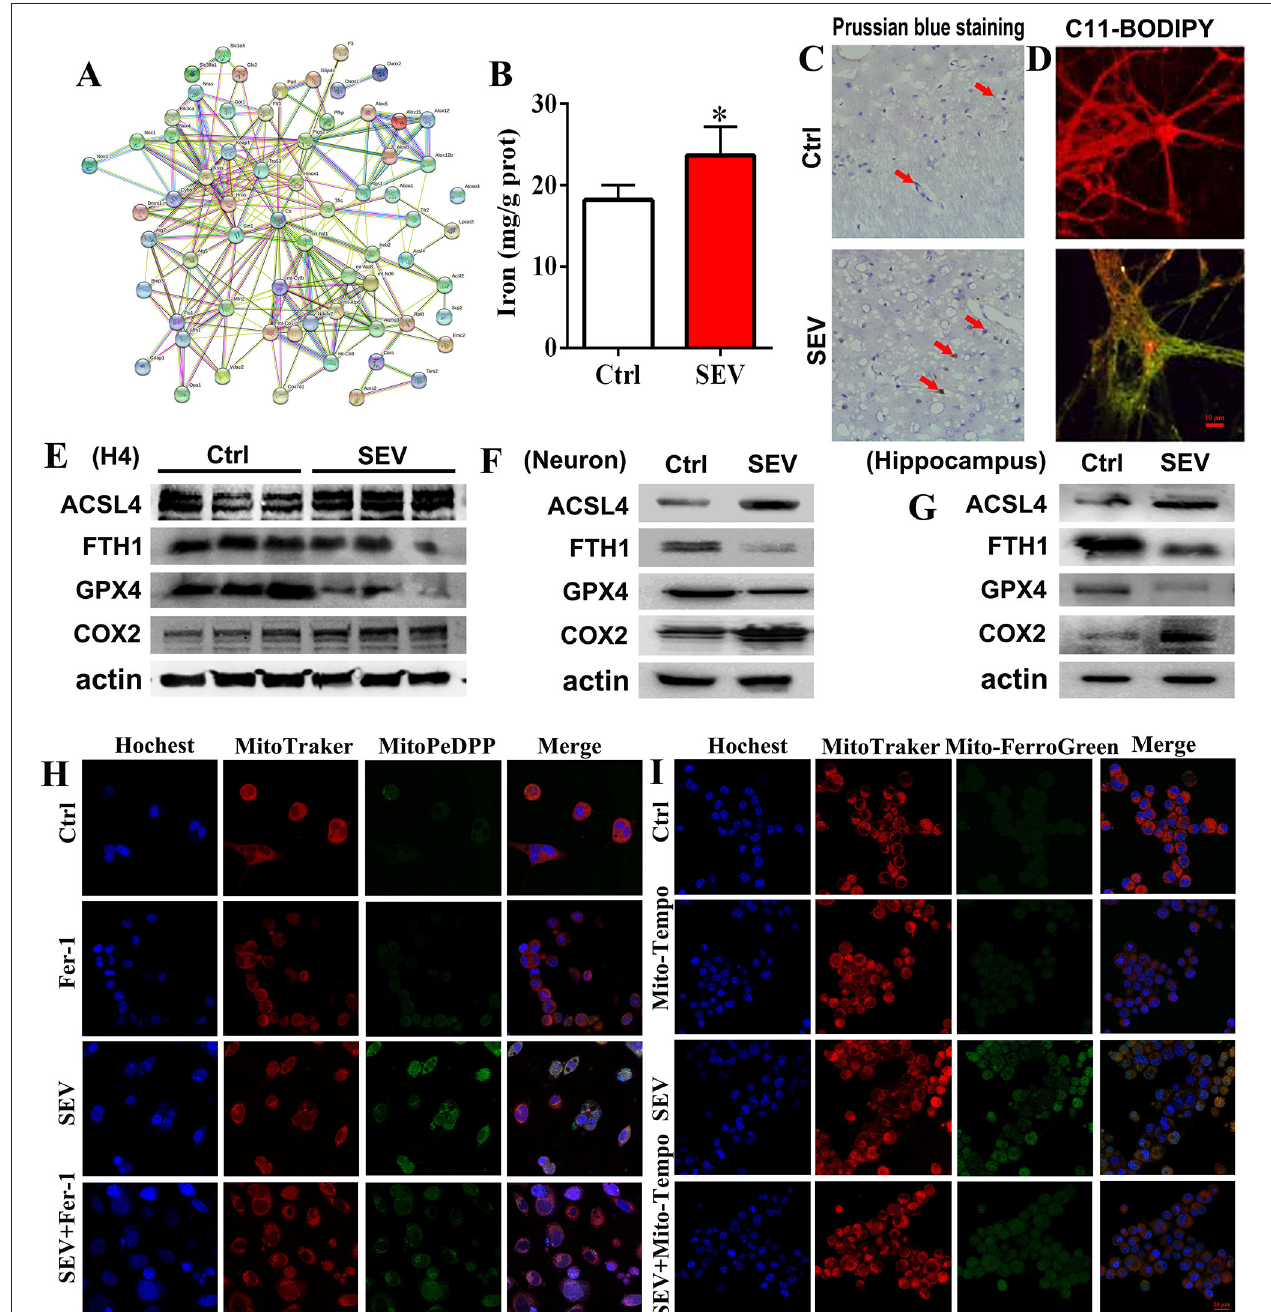
FIGURE 7 | Sevoflurane-induced mitochondrial dysfunction associated with ferroptosis. (A) Bioinformatic analysis for mitochondria and ferroptosis-related genes; (B,C) detection for iron content and distribution by iron assay and Prussian blue staining ( t- test, p = 0.0157); (D) C11-BODIPY staining for evaluating the lipid peroxidation level; (E–G) WB assay for measuring ACSL4, FTH1„GPX4 and COX2 protein expression; (H) mitochondrial lipid hydroperoxide evaluation by MitoPeDPP fluorescence dye; (I) mitochondrial iron content detection by Mito-FerroGreen staining. Scar bar = 10 µ m, applied in (D) ; Scar bar = 20 µ m in (H,I) . * p < 0.05, Ctrl vs.